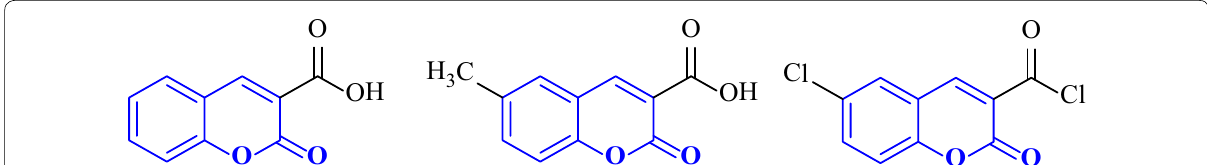
Fig. 55 Molecular structure of compound C50 , C51 and C52